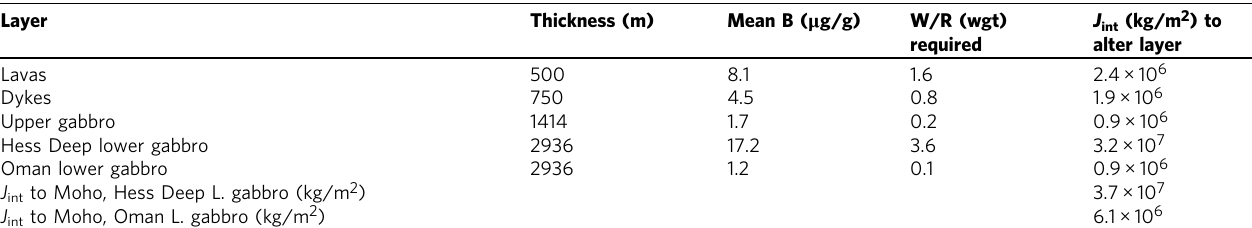
Table 2 1-D integrated fl ux ( J int ) fl ux calculations: mean values for lavas, dykes and upper gabbro, and Oman lower gabbro are based on Oman ophiolite 34 , with dykes within the lava pile assigned to that layer. Mean values for the lower gabbro are from Table 1. Layer thicknesses based on Gillis et al. (2014) 27 A: calculation of vertical water fl ux to Moho (based on